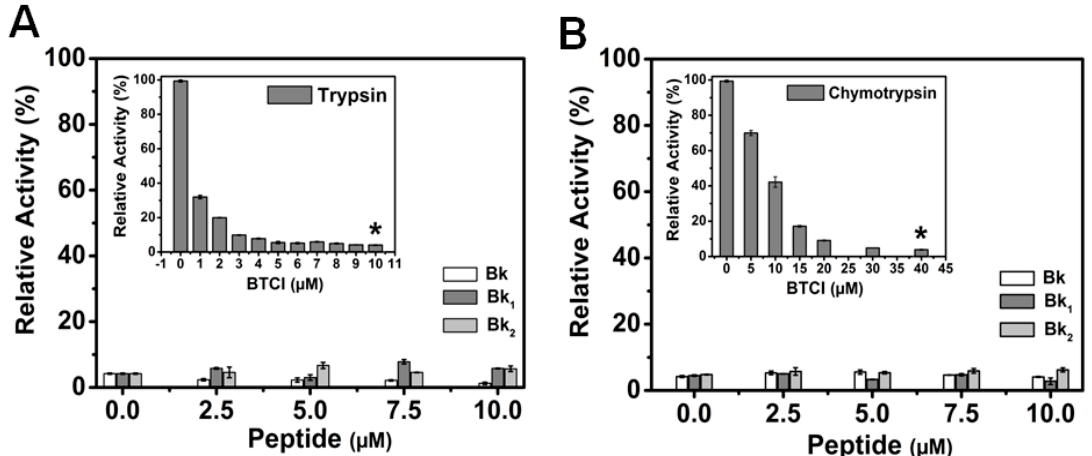
Figure 6. Trypsin and chymotrypsin activity in the presence of BTCI complexed with Bk and its analogues. ( A ) BTCI at 10 μ M was set as the standard concentration to inhibit trypsin activity (inset); ( B ) BTCI at 40 μ M was set as the standard concentration to inhibit chymotrypsin activity (inset). * p < 0.05 is compared with all other peptides at the same